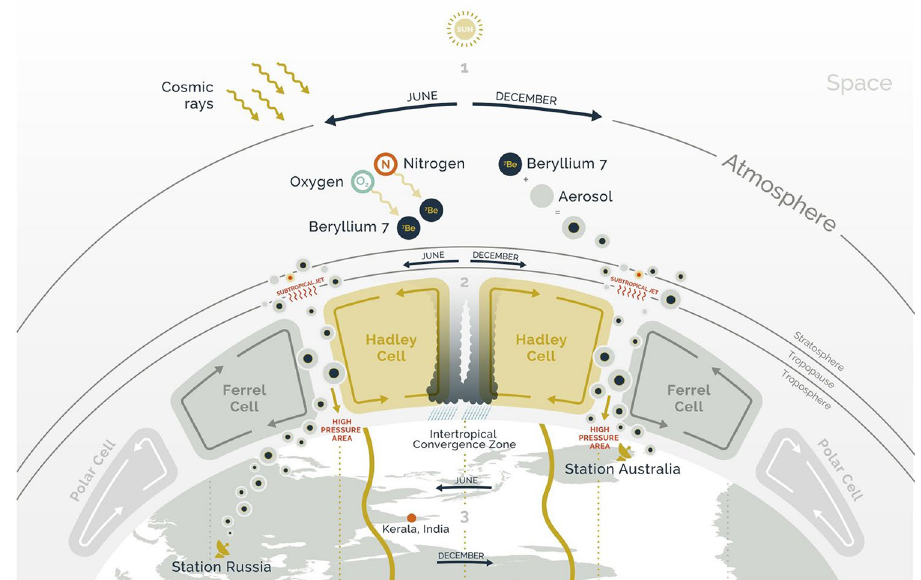
Figure 1. Points 1, 2, and 3 show the link between the heat produced by sunlight, earth rotation and Hadley cell progression with the monsoon pathway delimited by the intertropical convergence zone. Upper part: origination of beryllium-7. It is created through spallation from cosmic rays at high altitudes, attaches to aerosols and becomes detectable at monitoring stations on the earth’s surface after moving downwards with air masses due to atmospheric cell cycles. The vertical flux of air is going downward bringing greater quantities of fresh beryllium-7 toward the station. Lower part: the inter tropical convergence zone (ITCZ) follows the sun moving northward from January to June and southward from July to December. As the sun moves, the ITCZ moves and consequently also the Hadley-Ferrel and Polar cells. If a station is right below the ITCZ, the detected concentration of beryllium-7 will be low because the amount of beryllium-7 brought toward the station is washed out by rain and cannot be measured. Moreover, at ITCZ the vertical air flux is going upward so no fresh beryllium-7 reaches the surface where the station is located. If a station is right below the Hadley-Ferrel convergence zone (HFCZ), the concentration of beryllium-7 is high because the vertical flux of air is going downward bringing greater quantities of fresh beryllium-7 toward the station. Red dot indicates the region of Kerala in India, used as reference point of the Indian monsoon. High pressure area (red marked) indicates the surface location of high-pressure ridge formed in coincidence with the subtropical jet stream as a result of the Hadley circulation. mrprezident or